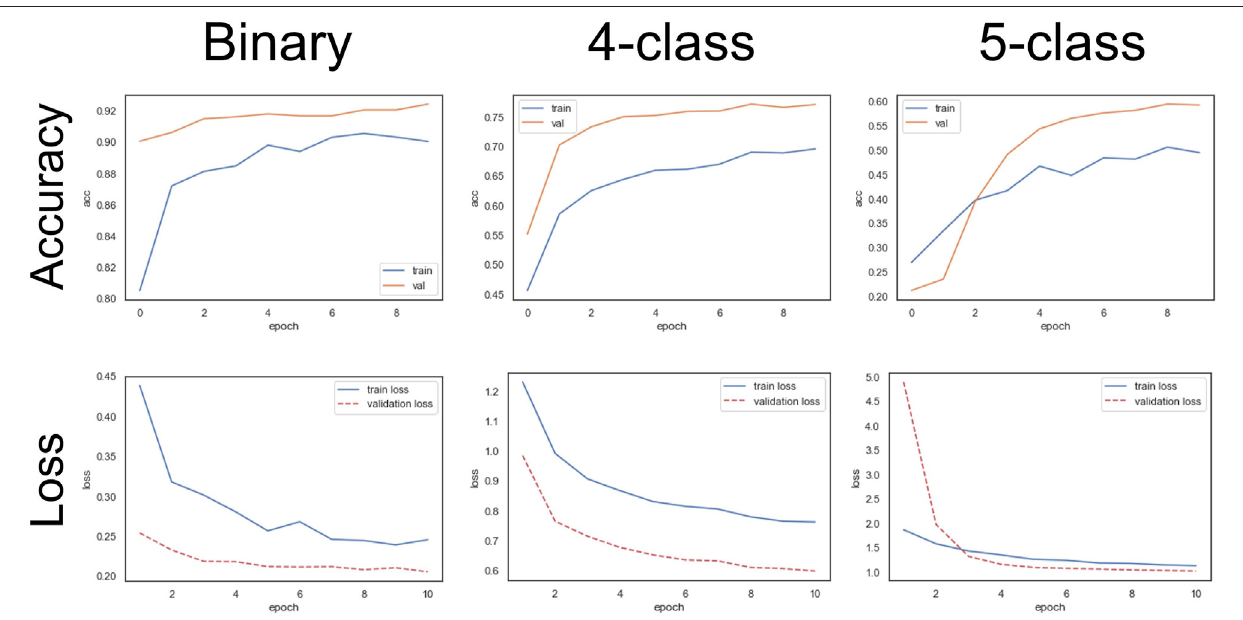
FIGURE 5 | CNN binary, 4-class, and 5-class models accuracy and loss curves for training and validation datasets.